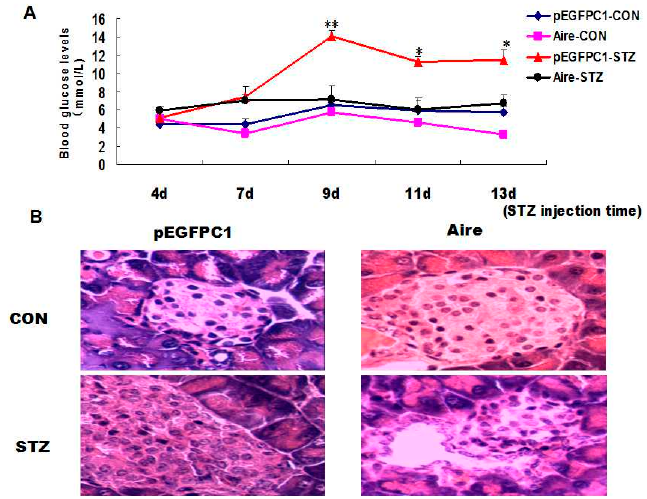
Figure 4. Adoptive transfer of Aire cell-co-cultured splenocytes delayed the development of type 1 diabetes. Splenocytes from WT mice were co-cultured with Aire or control cells for 48 h. Then, the lymphocytes were collected and injected into WT mice by the tail vein, followed by the induction of diabetes with STZ. ( A ) The blood glucose levels in mice transferred spleen lymphocytes; ( B ) the histology of pancreas of mice transferred spleen lymphocytes with H&E staining, n = 5 in each group, * p < 0.05, ** p < 0.01, Aire vs . pEGFPC1; Original magnification, ×200.